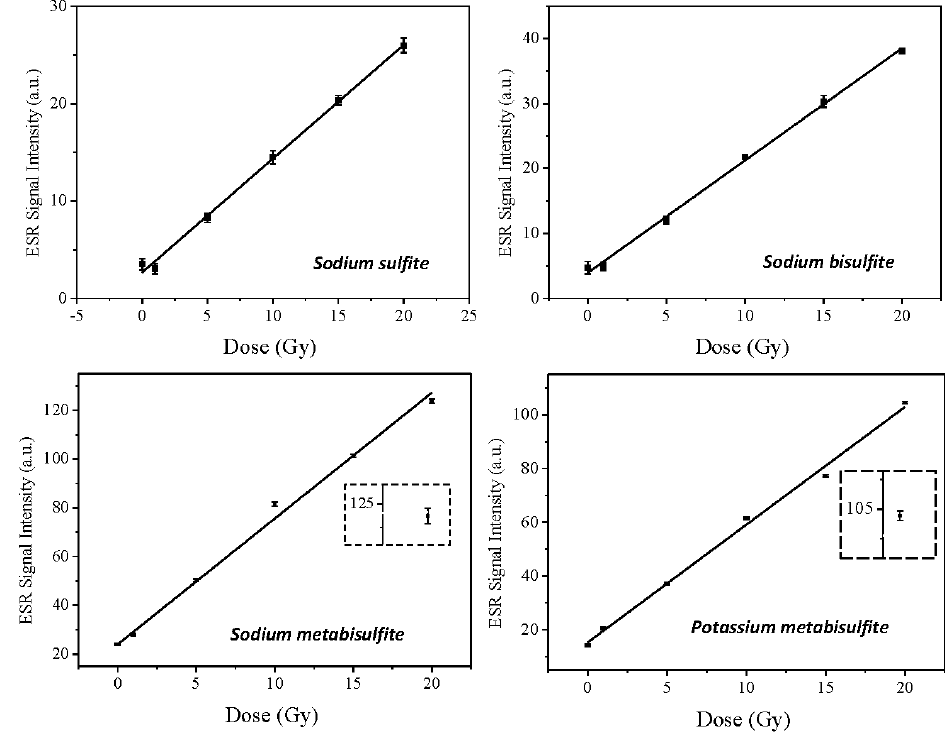
Figure 6. Dose–Response curves of sulfites studied. Linear fitting was used to simplify the data fitting. The inset shows the error box associated with the highest dose for the metabisulfite plots. Table 3. Parameters of fitting of Dose – Response Curve for each compound studied.